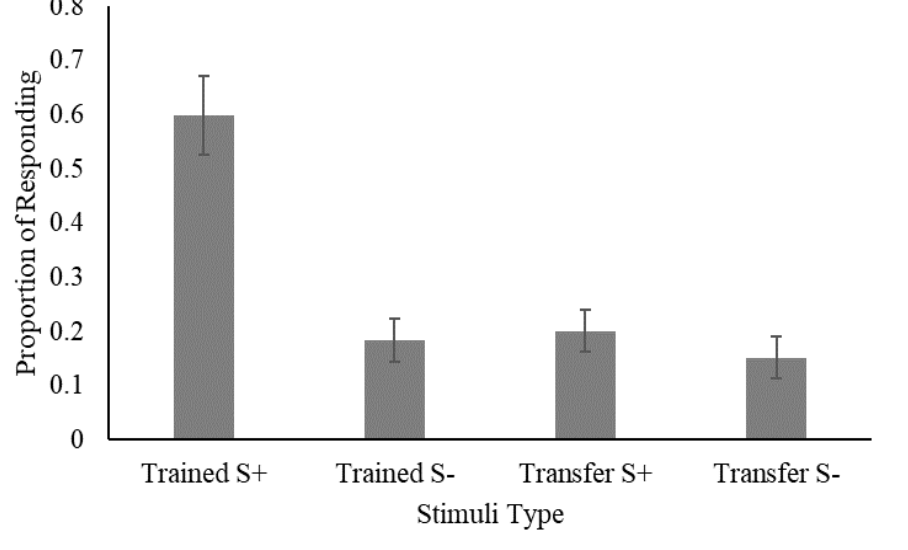
Figure 3 . True Group proportion of responding to Trained and Transfer stimuli. Error bars are standard error of the mean